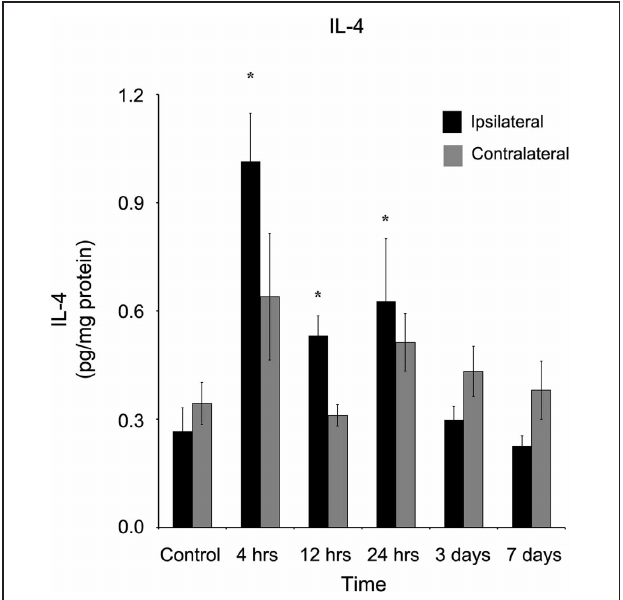
FIGURE 5 | IL-4 concentration increases in the ipsilateral cortex following a controlled cortical impact. Within four hours of a brain injury, and persisting for 24 hours, IL-4 increases ( p < 0 . 05) in the ipsilateral cortex in comparison to control tissue. There was no difference ( p > 0 . 05) between the ipsilateral and contralateral hemispheres at any time point measured. All values are mean ± SEM, n = 5. ∗ At each time point noted, ipsilateral differs from control tissue, p < 0 .